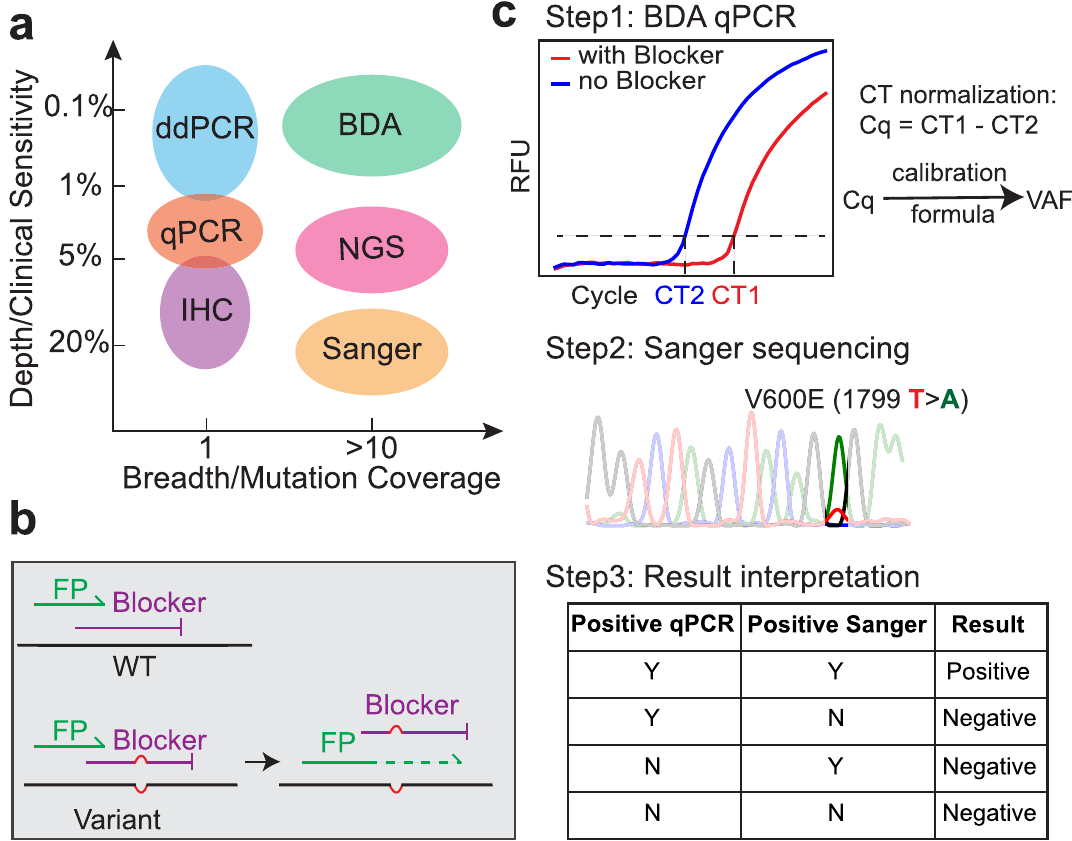
Figure 1. Methods for detection of BRAF mutations. ( a ) Comparison of depth and breadth of available BRAF mutation detection methods. ( b ) Mechanism for BDA variant enrichment 25 . The Blocker preferentially binds to and suppresses the PCR amplification of wildtype (WT) DNA sequences, resulting in selective amplification of BRAF mutations. ( c ) Workflow of BDA mutation detection assay. BDA is first performed in qPCR, and the amplicons are subsequently Sanger sequenced to identify the specific